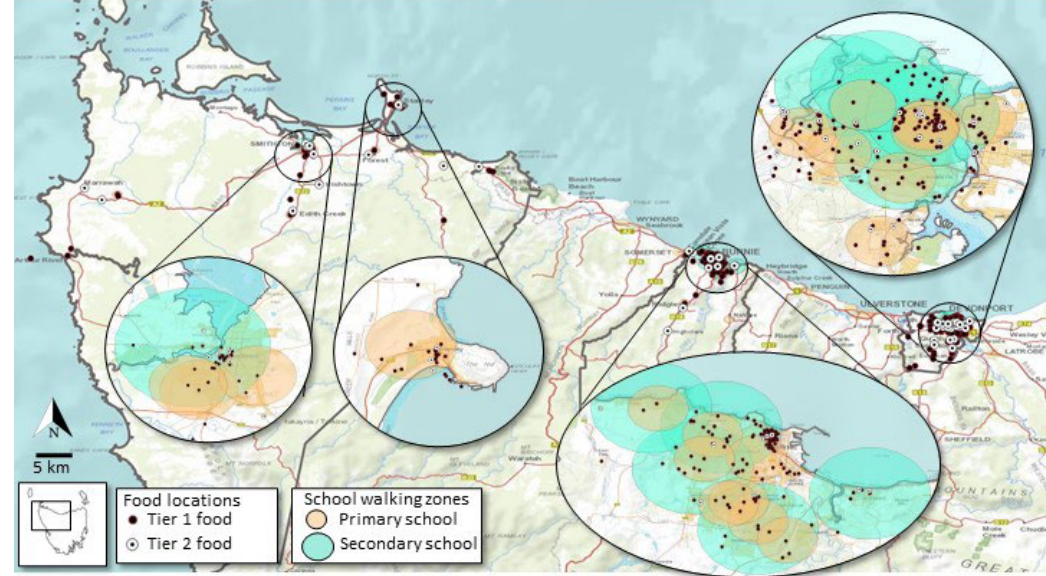
Figure 3. Access to Tier 1 and Tier 2 food outlets. Table 3. Abundance of Tier 2 (unhealthy) and Tier 1 (healthy) food outlets within walking distance of primary and secondary schools.